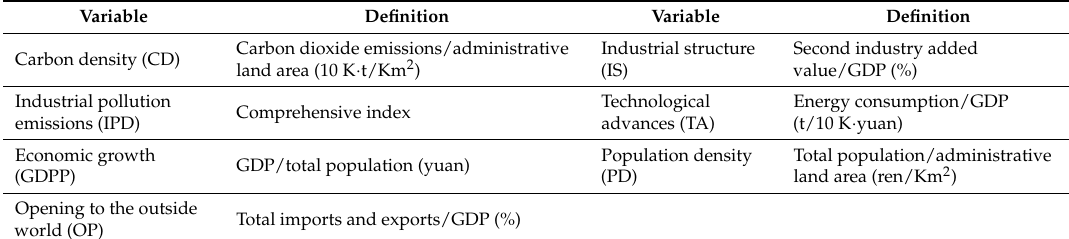
Table 1. Definition of all variables.